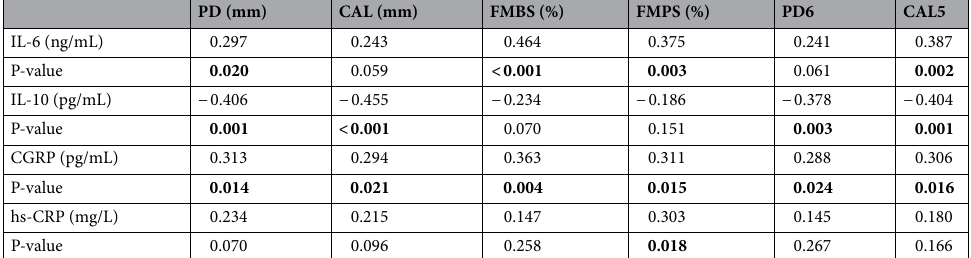
Table 2. Pearson’s correlation coefficient for clinical periodontal parameters and biomarkers (N = 61). CAL clinical attachment level, CAL5 number of periodontal pockets with CAL ≥ 5 mm, FMBS full-mouth gingival bleeding score, FMPS full-mouth plaque score, PD pocket depth, PD6 number of periodontal pockets with PD ≥ 6